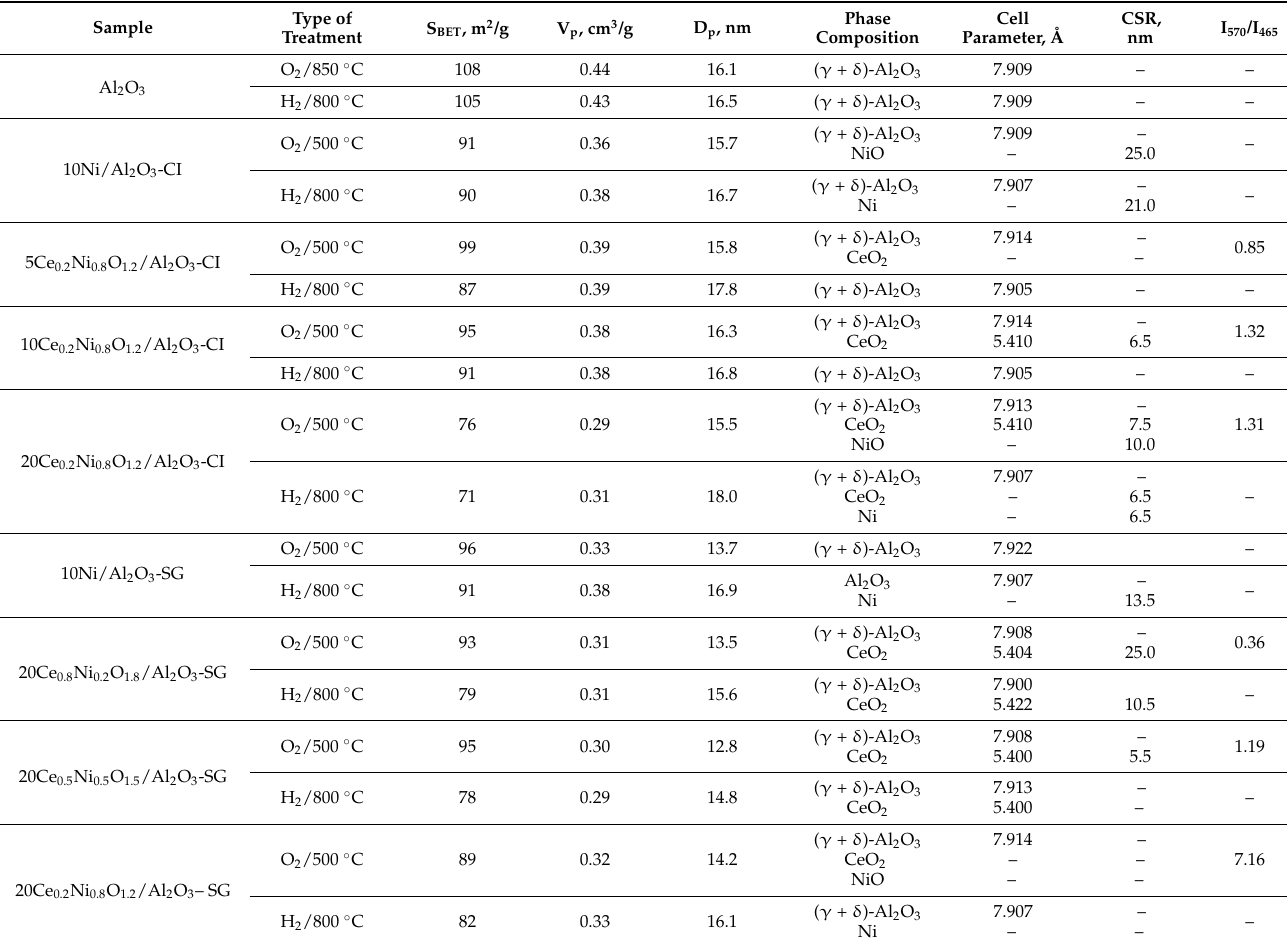
Table 2. Characteristics of the Ce 1 − x Ni x O 2 − x /Al 2 O 3 catalysts before reaction